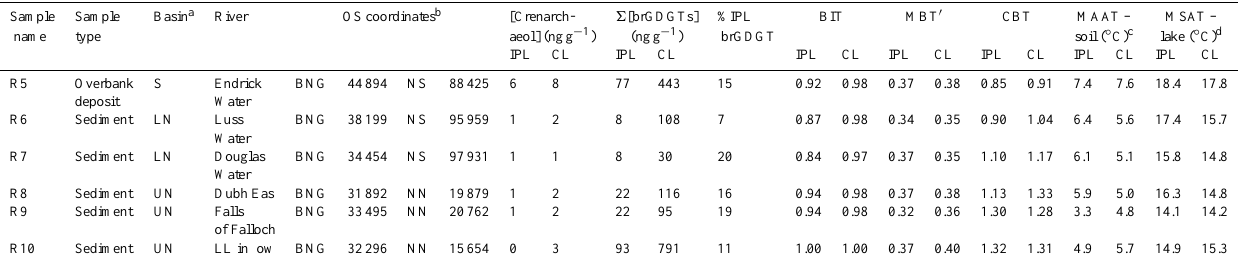
Table 3. River sediment data: crenarchaeol and summed brGDGT concentrations, BIT indices, MBT 0 indices, CBT ratios, inferred mean annual air temperatures (MAATs) and inferred mean summer air temperatures